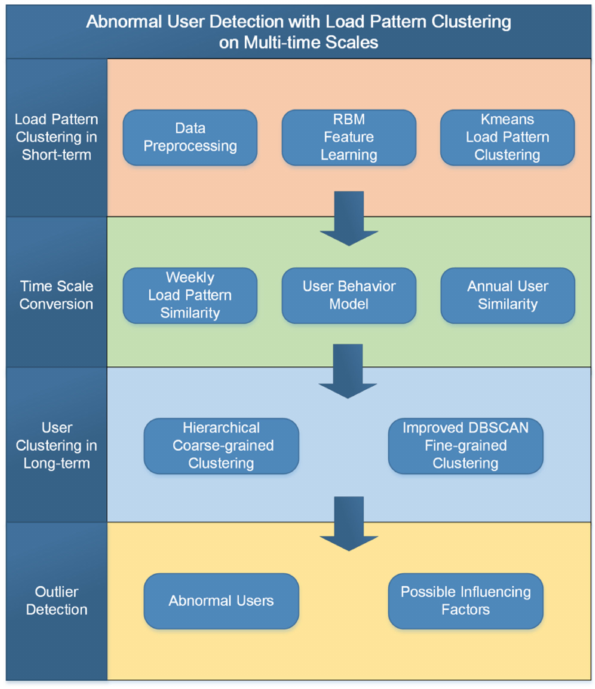
Figure 1. The overall process of AUD-MTS